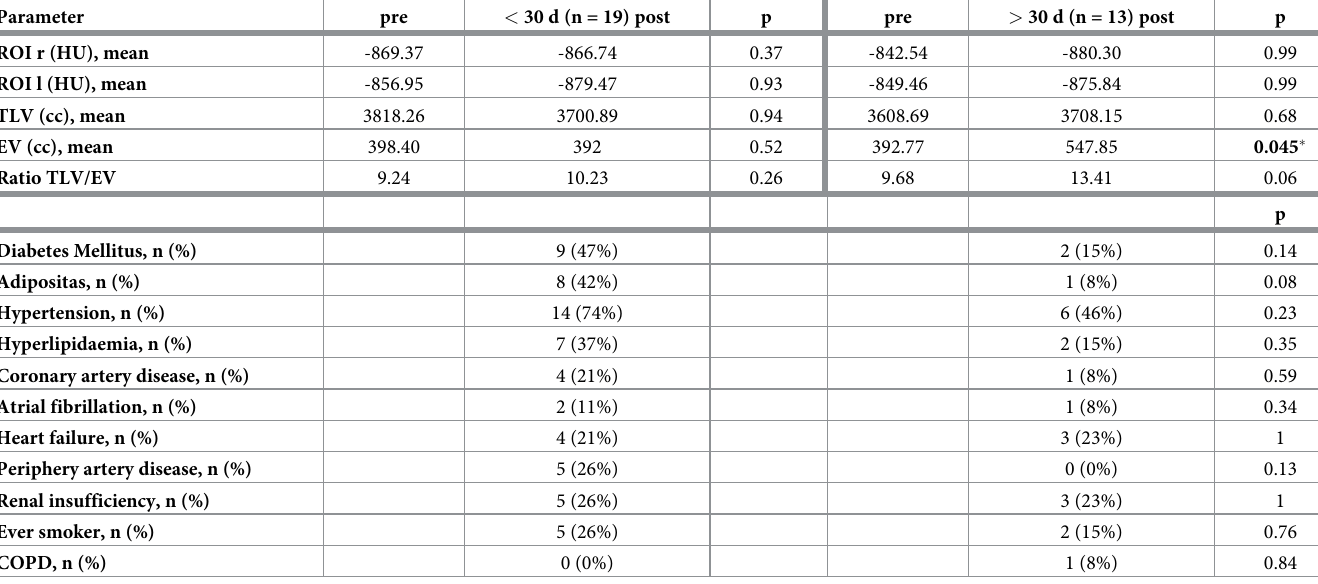
ROI–region of interest, TLV–total lung volume, EV–emphysema volume, COPD–chronic obstructive pulmonary disease, cc–cubic centimeters, d–days, n–count � —statistically